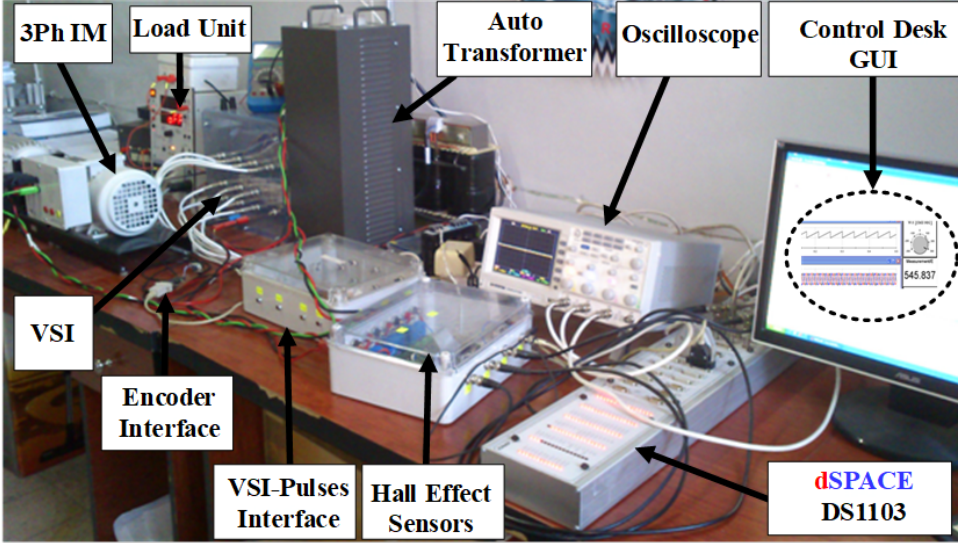
Figure 32. The experimental platform implemented to test the combined FOC-DTC